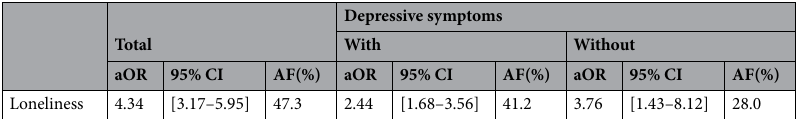
Table 3. Association between loneliness and suicidal thoughts in the total sample and categorized by whether individuals had depressive symptoms. Binary logistic regression models and attributable fractions. Adjusted on age, gender, inclusion period, interactions by phone, interactions on social network, marital status and history of psychiatric disorders. AF attributable